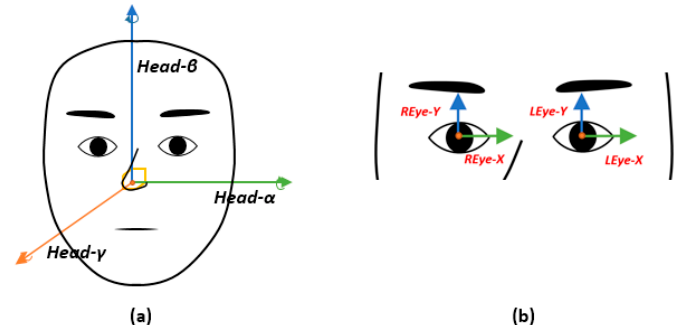
Figure 3. Coordinate axes: ( a ) face and ( b ) eye.